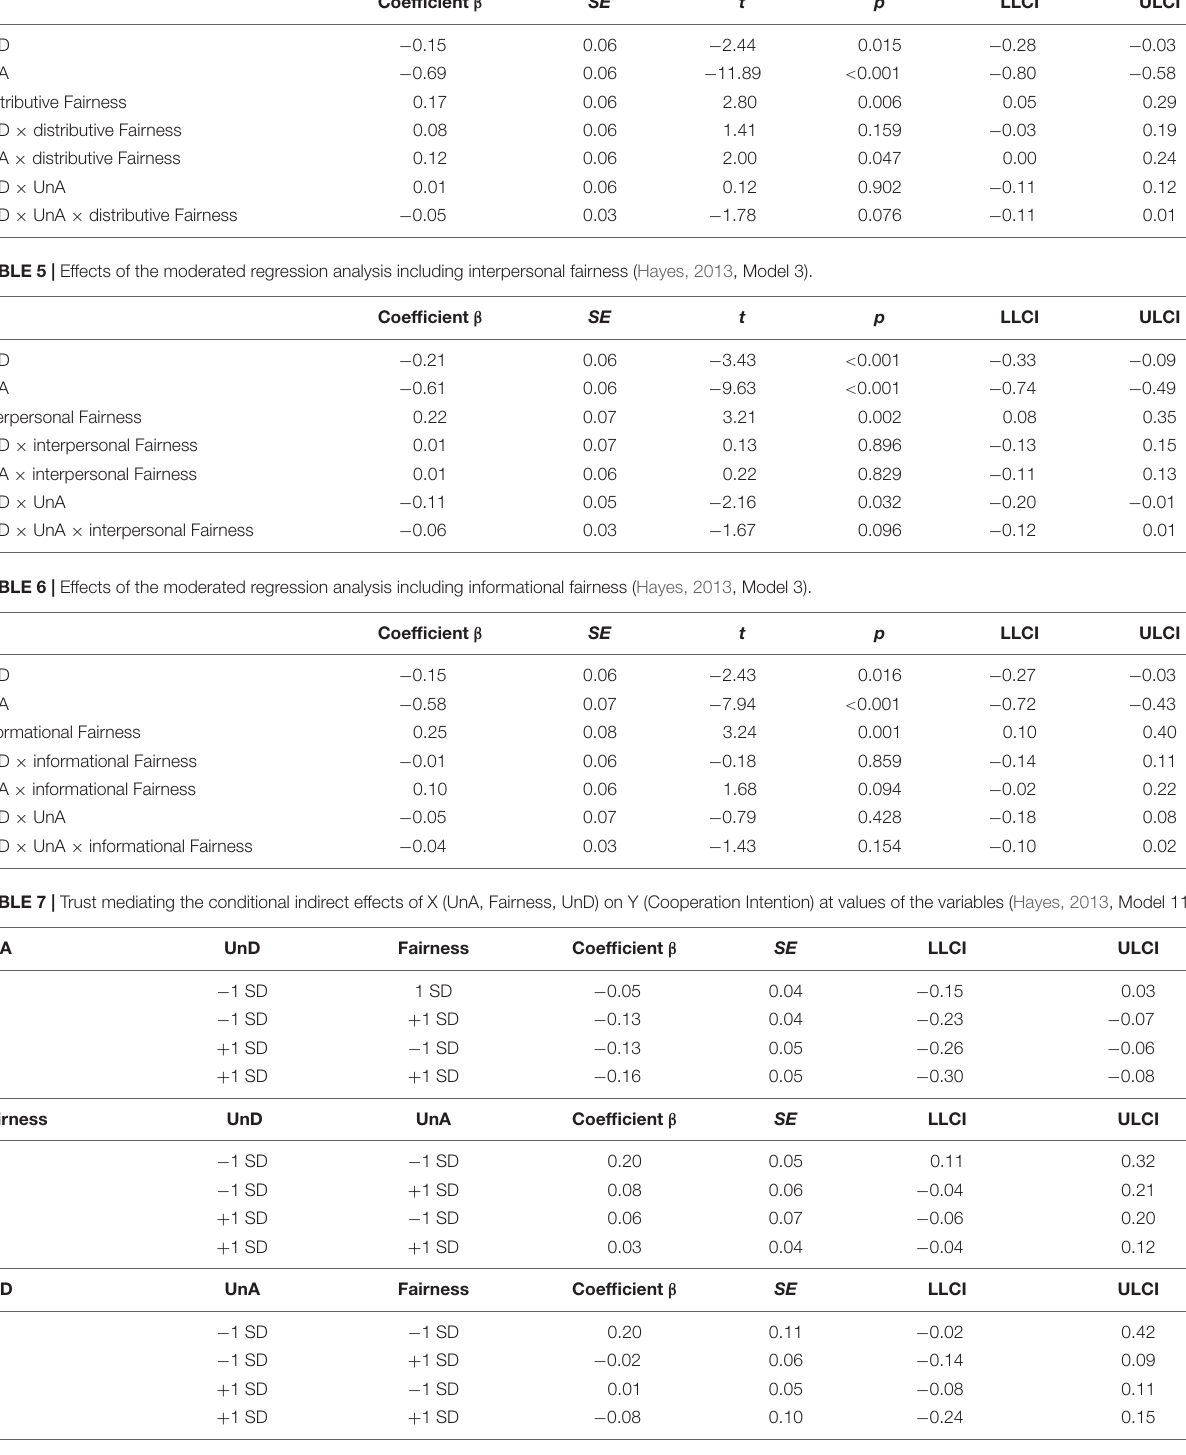
TABLE 4 | Effects of the moderated regression analysis including distributive fairness (Hayes, 2013, Model 3). Coefficient β